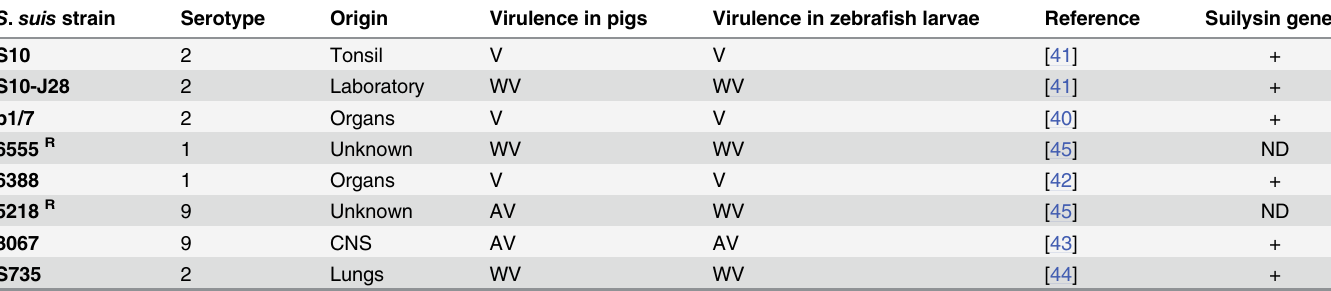
Table 2. S . suis isolates and their relative virulence in zebrafish larvae and in pig infection studies. S . suis